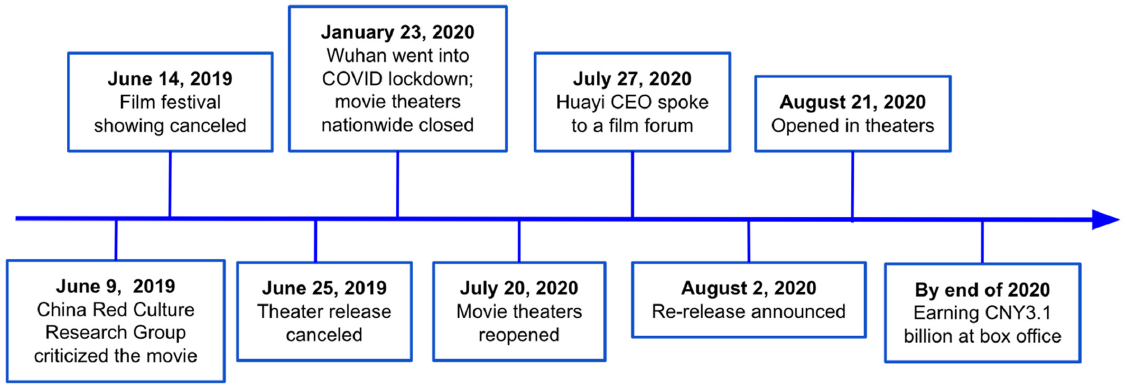
Figure 1. Timeline of key events of “800”.